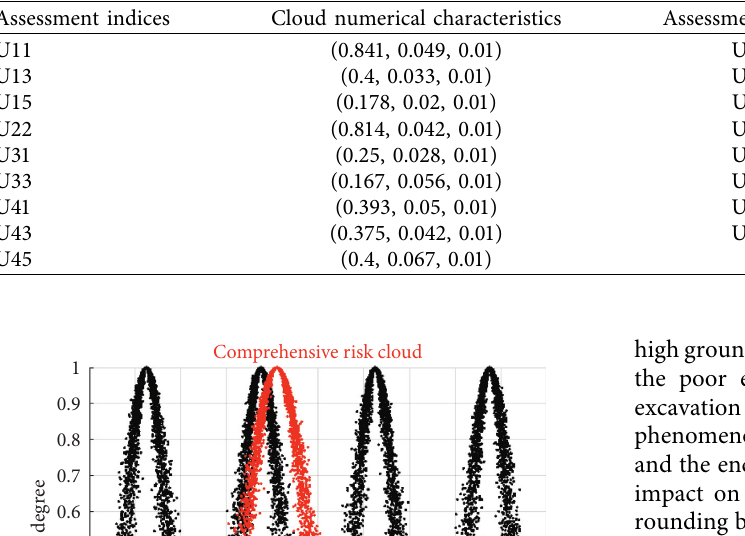
Table 9: Cloud numerical characteristics of all evaluation indices.